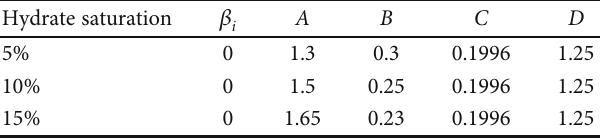
Table 1: Combination of parameters used in formula (12). Hydrate